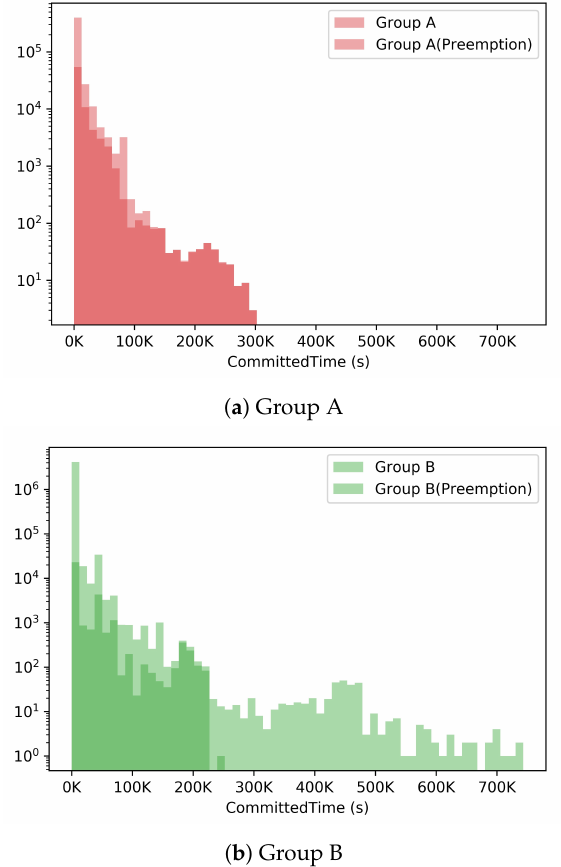
Figure 9. Distribution of preempted jobs by committed time.